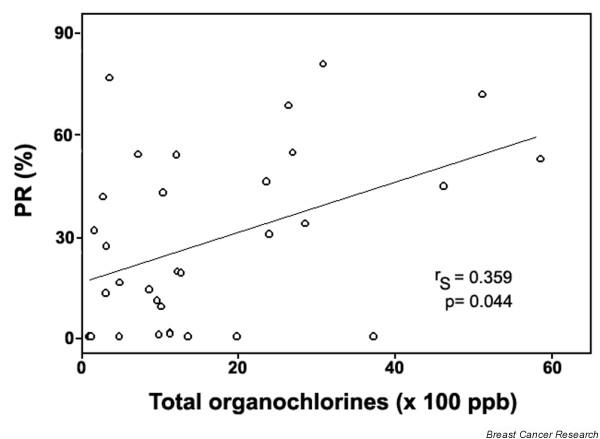
Organochlorine levels modulate progesterone receptor expression in estrogen receptor-α positive breast carcinomas. The percentage of PR expression in ERα-positive breast carcinoma was positively correlated with organochlorine levels in the adjacent adipose tissue (Spearman's Rho test, P = 0.044).